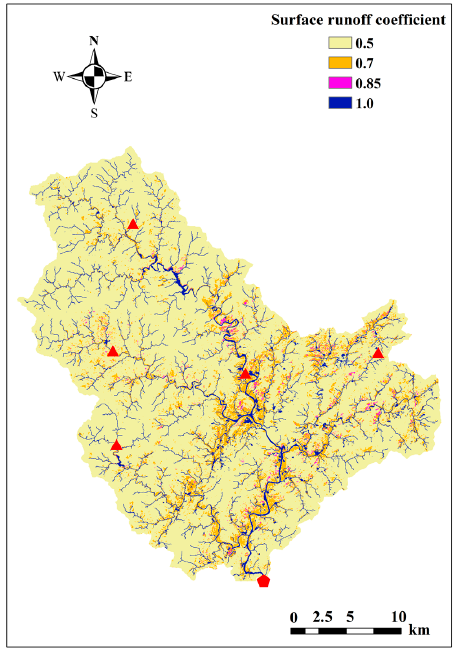
Figure 3. The spatial distribution of surface runoff coefficient 4 (SRC4).